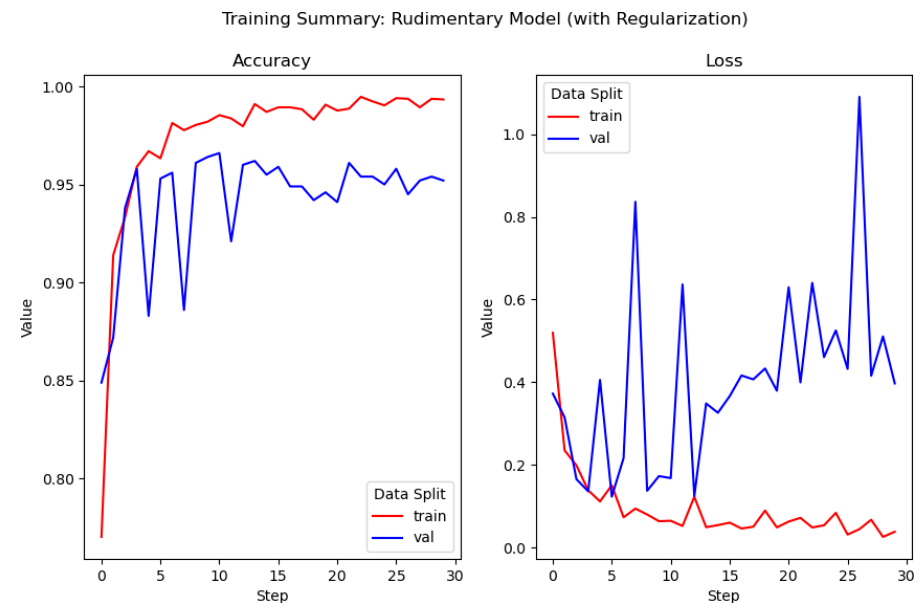
Figure 7. Training summary of the rudimentary CNN model with regularization via dropout layers.